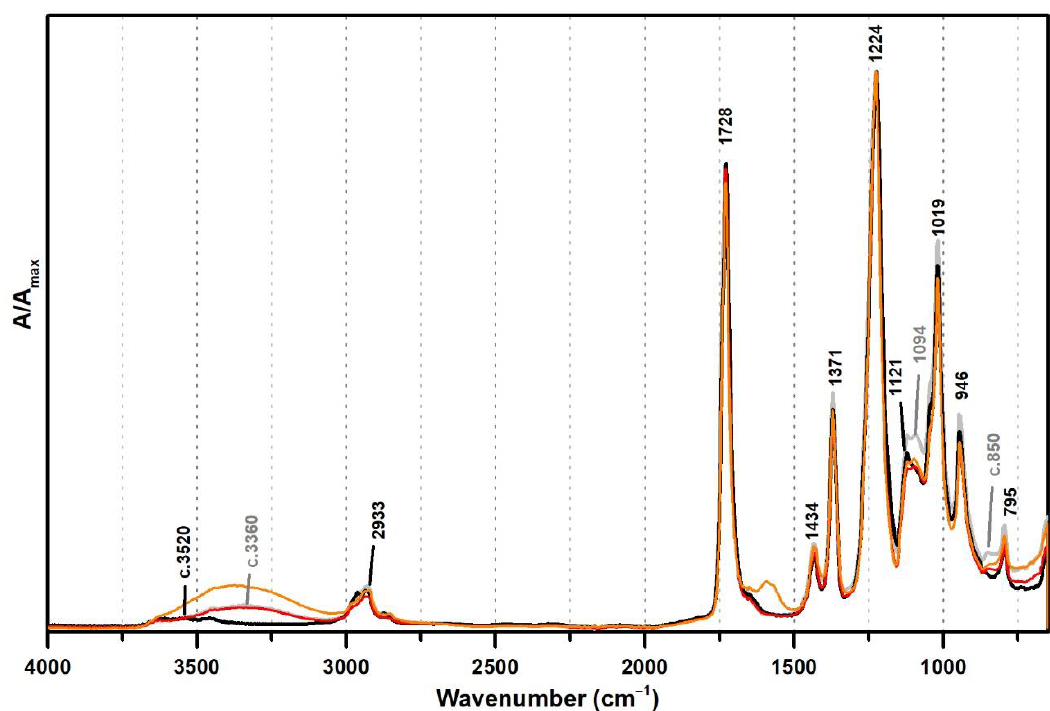
Figure 2. Infrared spectra in ATR of the vinyl acetate emulsion films: pure PVAc (black), PVAc stabilised with 10% of PVAl (grey), Polidisp 1080 (red), and Polidisp DH (orange). According to technical data sheet, the Polidisp emulsions in these spectra are composed of PVAc stabilised with PVAl.